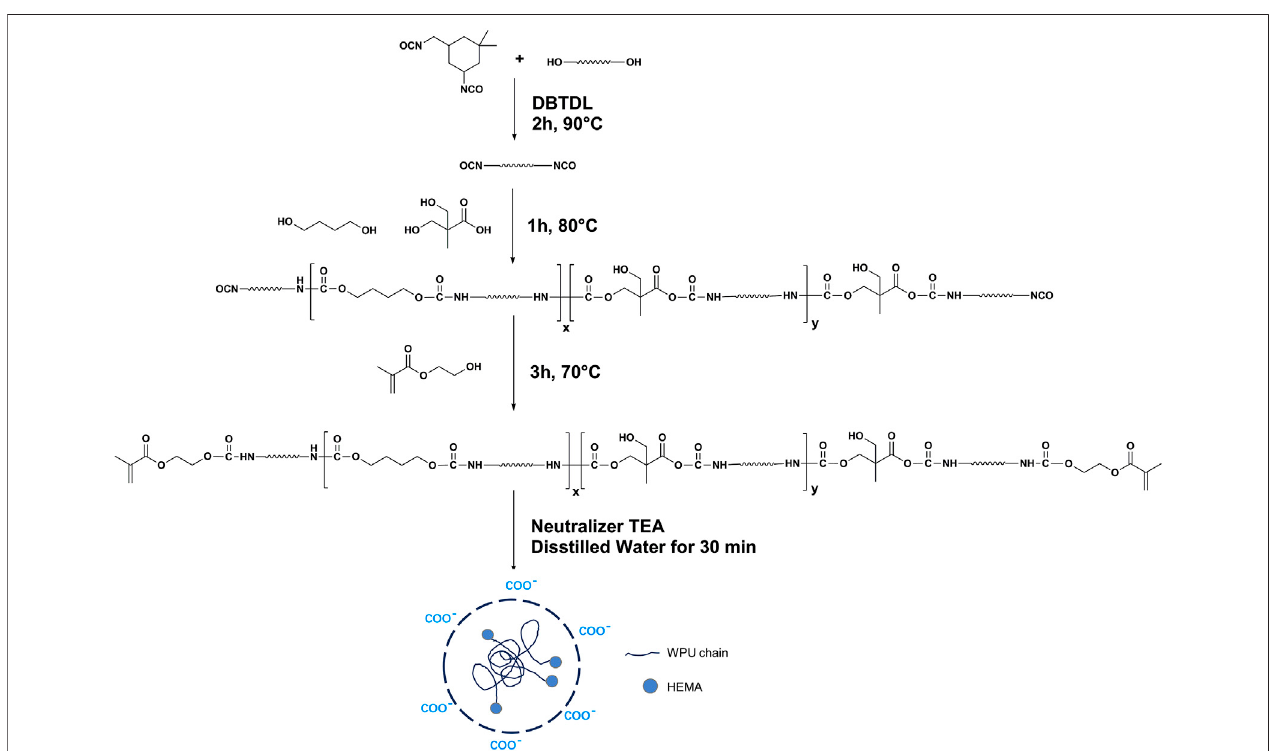
FIGURE 1 | Schematic of reaction scheme for EMWPU synthesis and EMWPU emulsion microstructure.